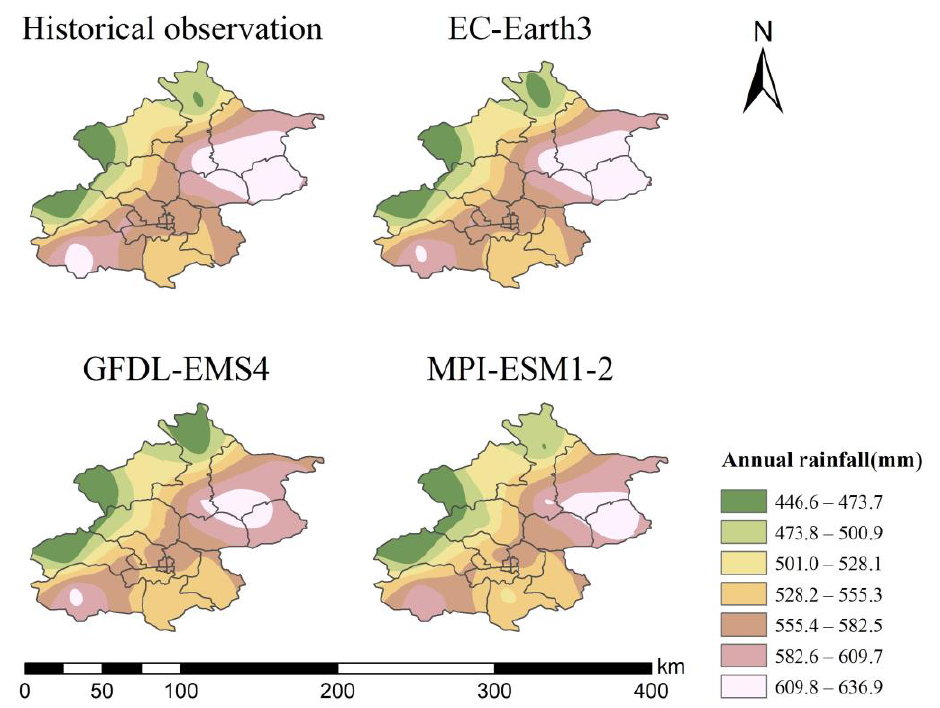
Figure 2. The historical annual rainfall distribution of the observed data and three models’ downscaled data.